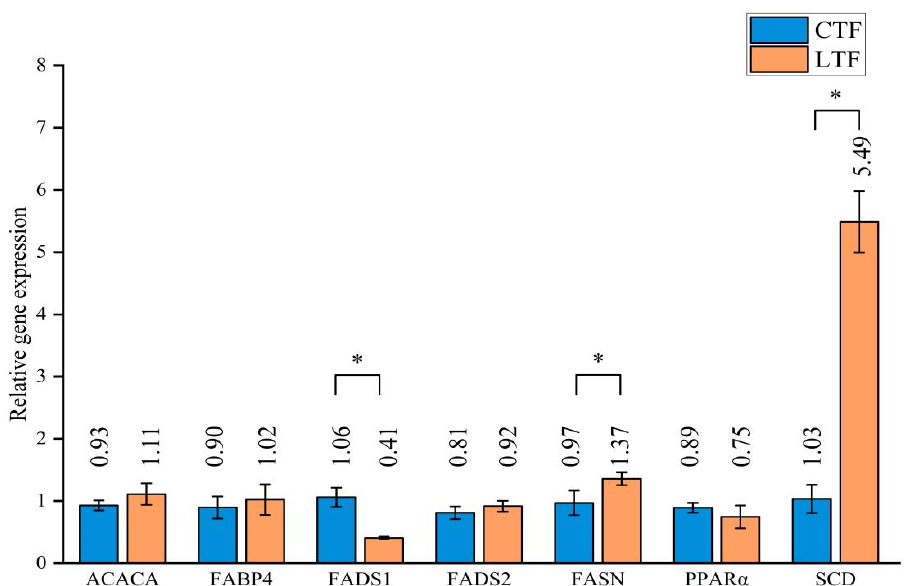
Figure 3. The relative expression of seven genes in the cecum. Data are expressed as average ± standard deviation. Note: CTF: control group (basal feed), LTF: experimental group (basal feed + Lactiplantibacillus plantarum). “*” indicates a significant difference between the two groups ( p < 0.05).